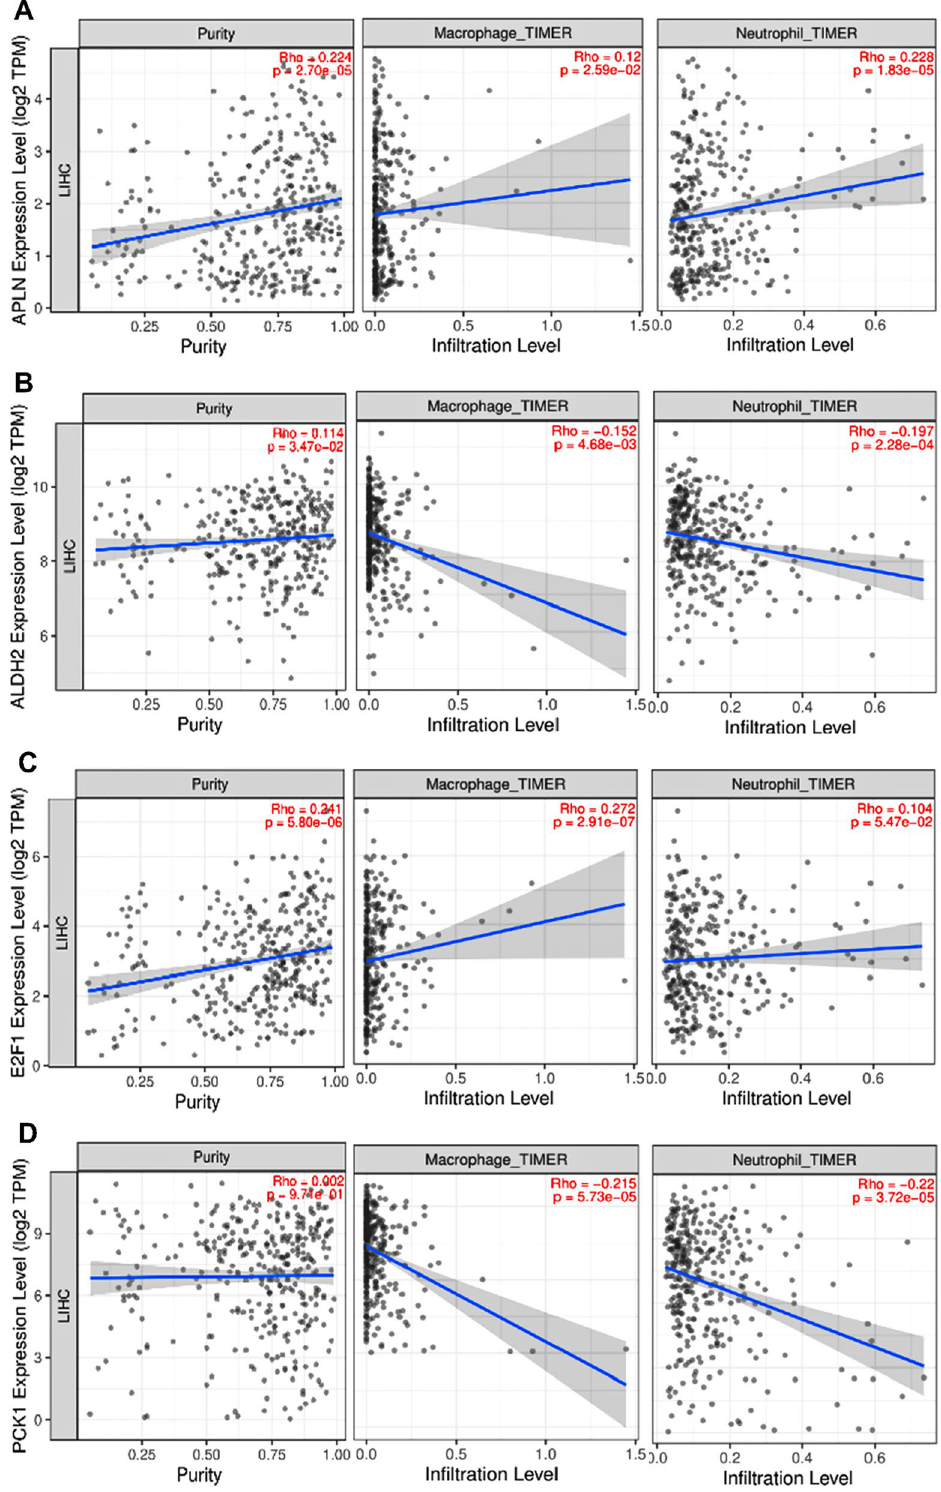
Fig. 8 Scatterplots showing significant correlations of A APLN, B ALDH2, C E2F1, and D PCK1 with infiltrating levels of neutrophils and macrophages across TCGA-HCC cohort. Spearman’s correlation value and estimated statistical significance were shown as the legends for each scatter